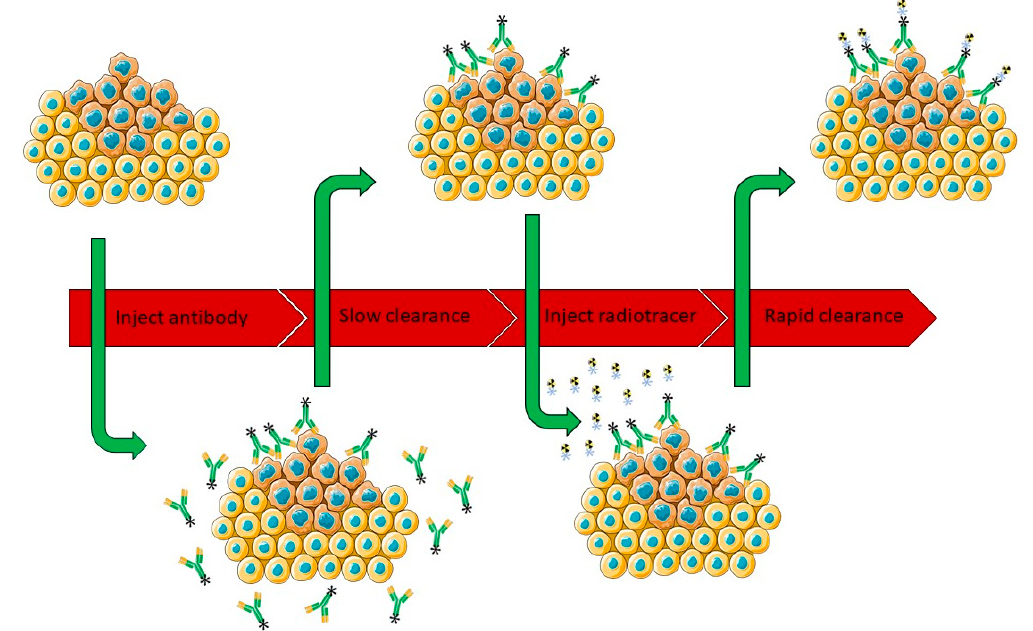
Figure 3. Pretargeting approach: In a first step an Ab with a targeting moiety is injected. Secondly the Ab is allowed to accumulate at tumor site over time. Thirdly a complementary radiolabeled probe is injected and lastly in vivo ligation of the Ab and the radioligand followed by rapid clearance of any excess of the radioligand (figure adapted under a Servier Creative Commons Attribution https://creativecommons.org/licenses/by/3.0/).